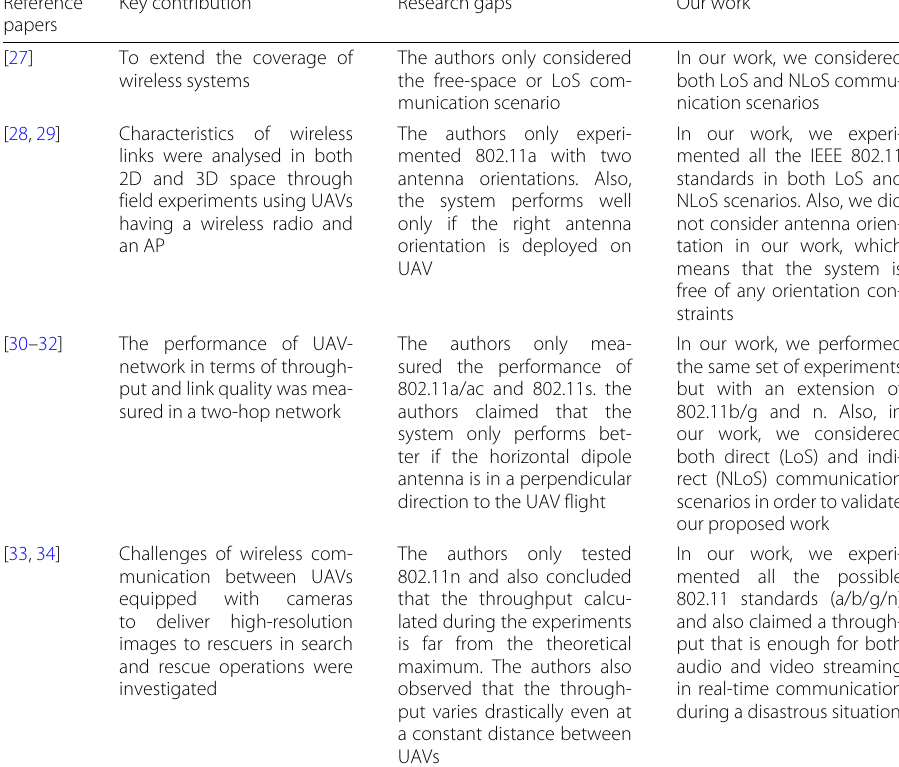
Table 1 Summary of related work Reference